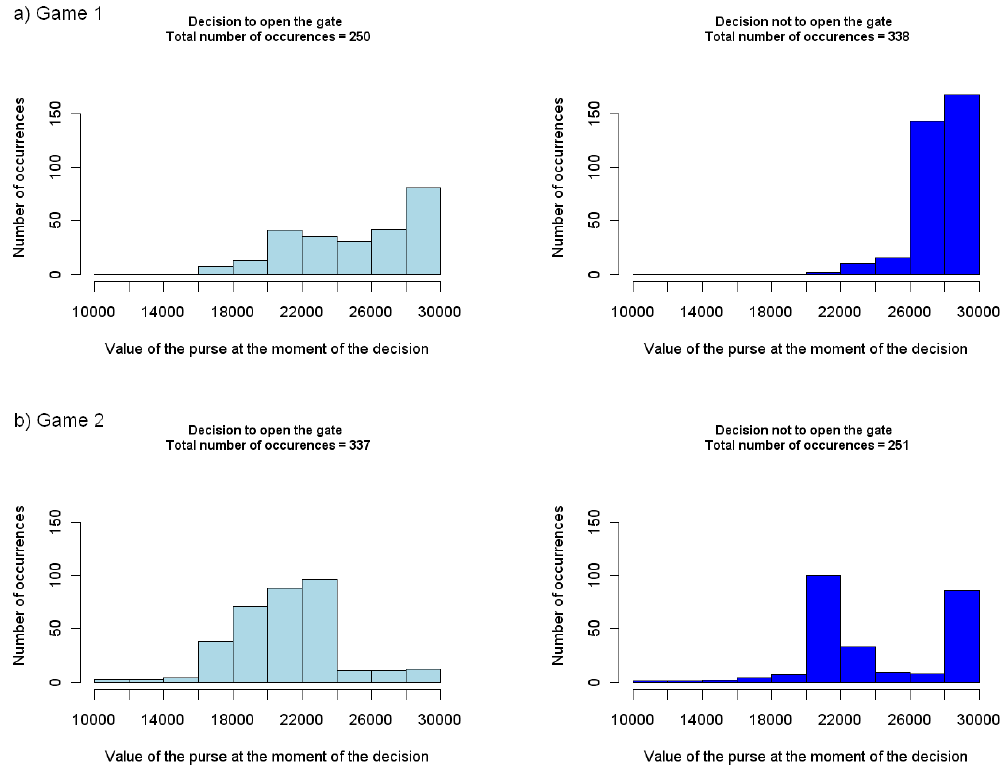
Fig. 8. Distribution of the values of the purses when participants decided to open the gate (“yes” answers towards a risk-avoiding attitude, left panel) or not to open the gate (“no” answers towards a risk-seeking attitude, right panel) during Game 1 with uncertainty information (top panels) and Game 2 without uncertainty information (bottom panels). Histograms cells are right-closed (left open) intervals.